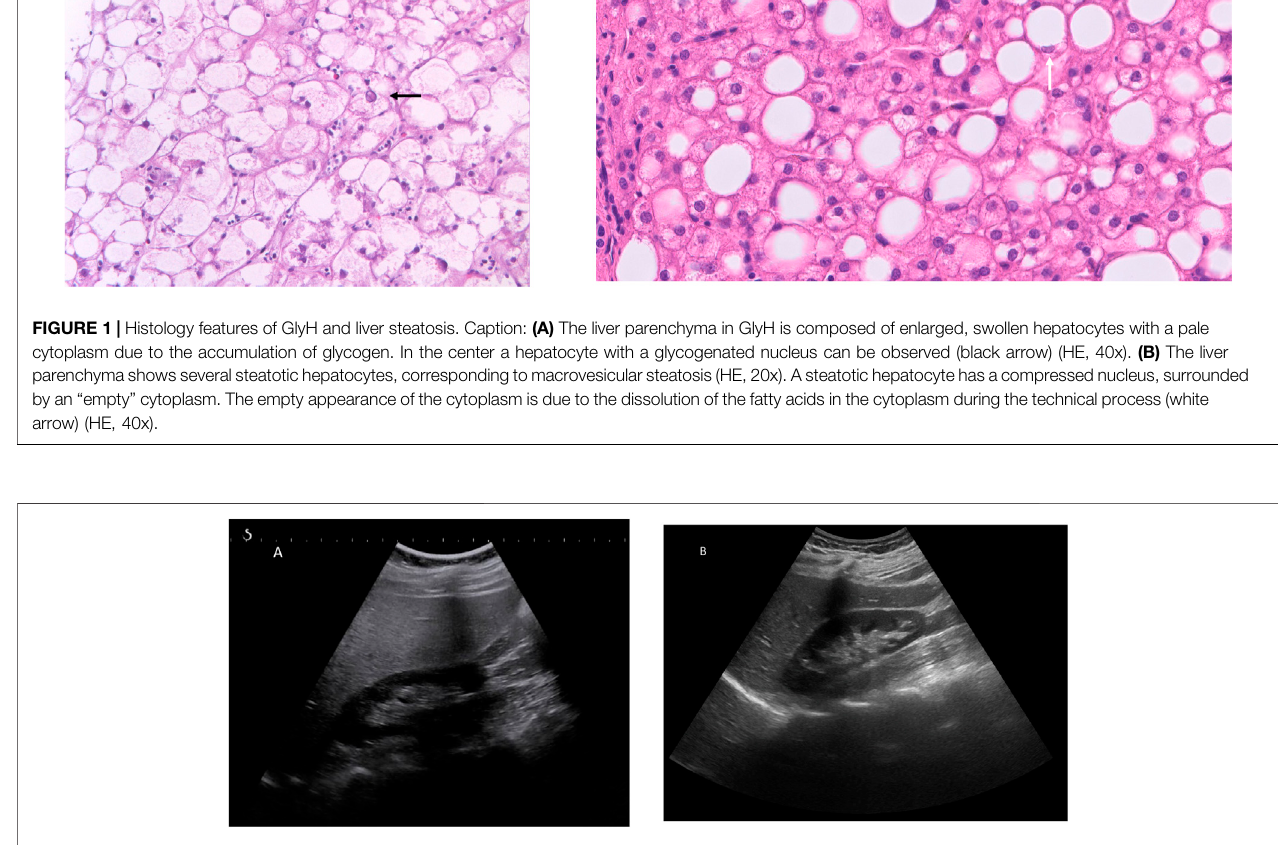
Frontiers in Pharmacology |